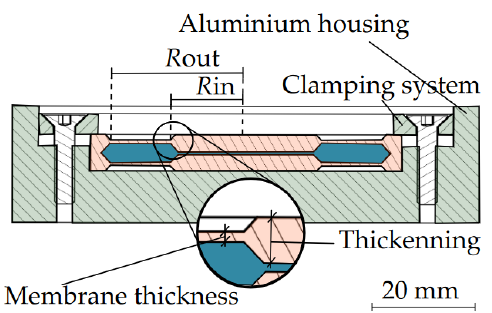
Figure 1. Render of the prototype ( left pane ) with designed membrane thicknesses 0.6mm and 0.8mm and a cross-section image ( right pane ). In the middle of the membrane the thickened part can be seen. The larger of the two threaded connections is used as feeding hole, the smaller one is used as venting hole.